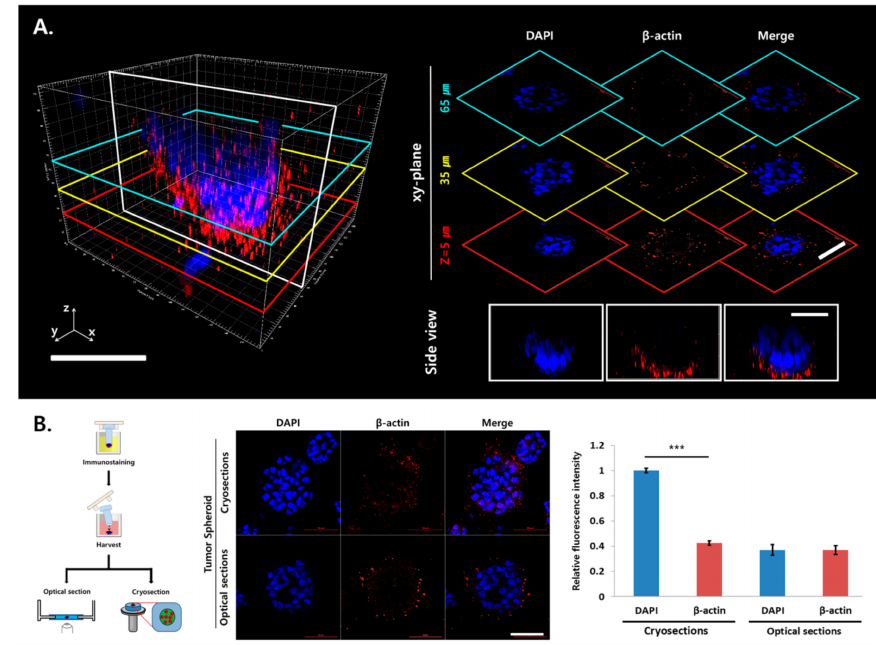
Figure 2. Limited penetration of immunolabeling antibodies in Capan-1 tumor spheroids (TSs). ( A ) Three-dimensional (3D)-rendered confocal images of a single Capan-1 TS following DAPI and β -actinstaining. Opticalsectionswereobtainedat5- µ mincrementsalongthe z -axisfor3Dreconstruction. ( B ) Fluorescence intensity of DAPI and β -actin was compared between optical sections and